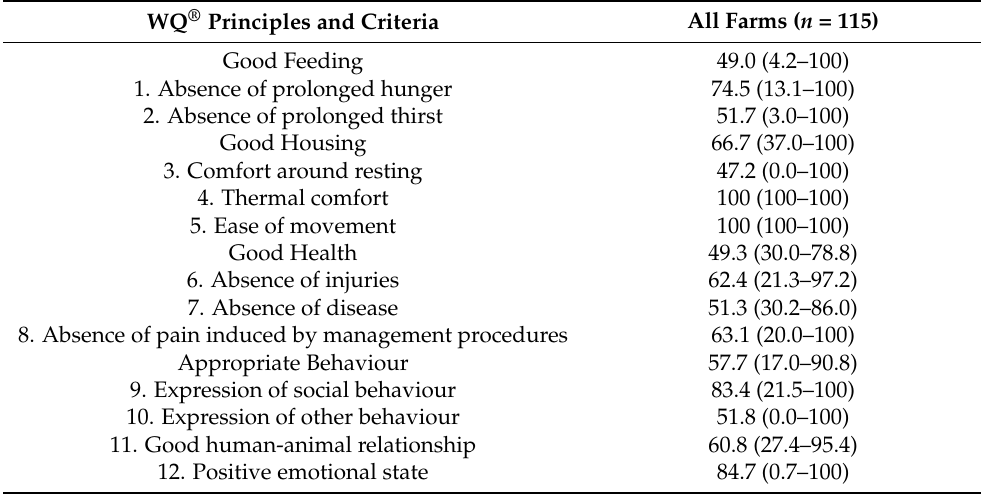
Table A2. Normative threshold values (mean) given by 21 and 17 scientists in the two rounds of the Delphi survey ( n = 12–17 with naming of threshold values for the single indicators) and 20 practitioners ( n = 8–9 with naming threshold values) and their comparison with the results of the on-farm survey ( n = 115, Quartile 1 and 3; Q = Quartile). Indicators excluded from the final list are green formatted. Indicators added to the final list are green formatted. Indicator Scientists Practitioners Farm Survey ( n = 115) with Naming of Threshold Values n = 12–17 n = 8/9 Q1 Q3 n Mastitis: Cows with SCC >400,000/mL in milk 1 % Ketosis: Cows with milk fat-protein-ratio ≥ 1.5 within 100 days p.p. 1